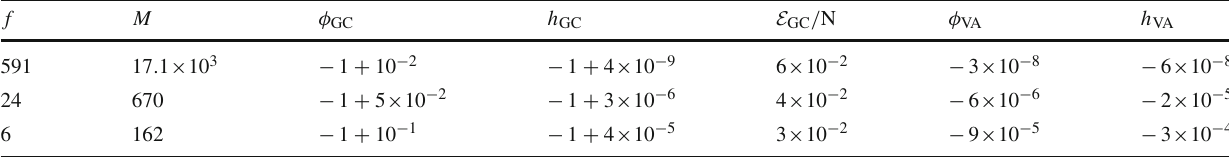
vacuum energy at the VA point is always in very good agreement with N f 2 / 2 and therefore we do not write it explicitly. Note that, because we are interested in the orders of magnitude and in the possible existence of a solution, we have rounded-up the presented numerical